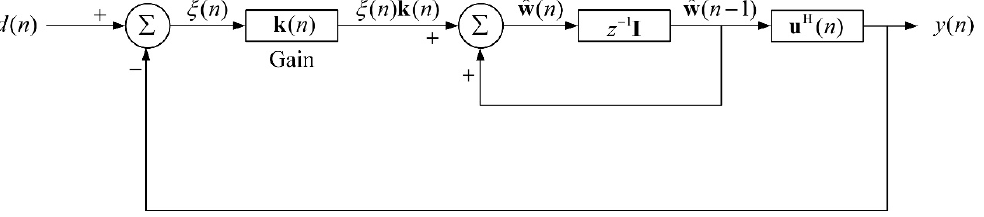
Figure 2. Signal ‐ flow graph of ARLSF. Figure 2. Signal-flow graph of